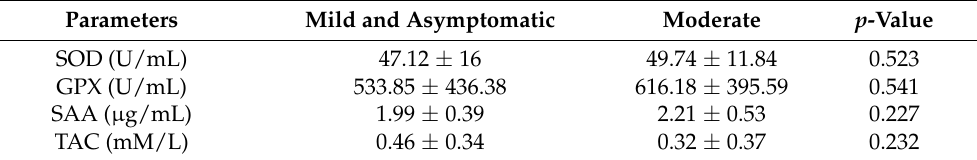
Table 3. Differences in the study parameters between patients who had different disease severities *.